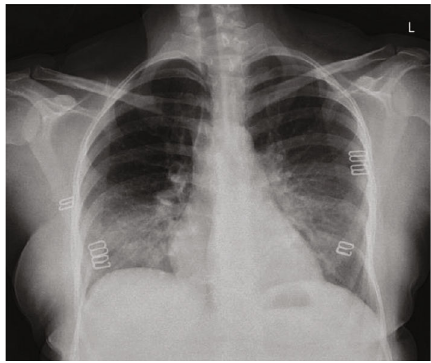
Figure 1: Brain CT scan showing no space occupying lesions nor hemorrhage in the parenchyma, a normal ventricular system with no hydrocephalus and no midline shift.